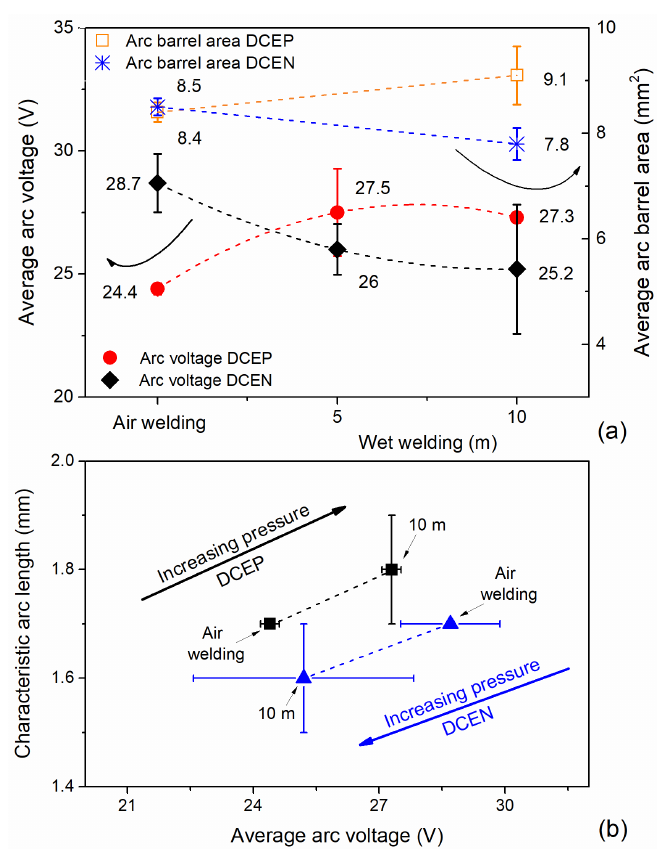
Figure 6. ( a ) Average arc voltage and arc barrel area for the rutile electrode in both polarities and for all conditions; ( b ) characteristic arc length vs. average arc voltage. Error bars show the standard deviation.